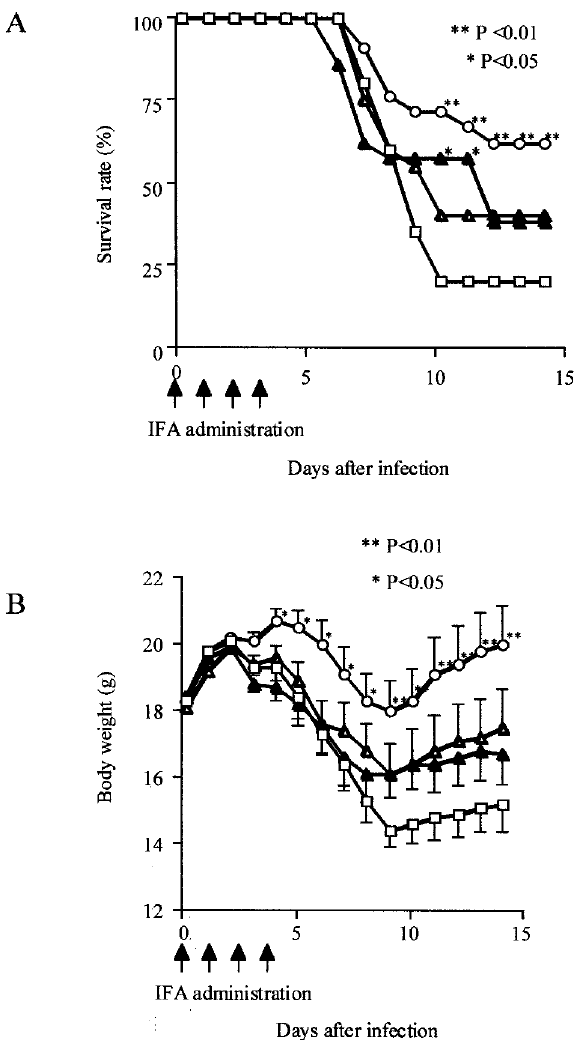
FIG. 1. (A) Effect of isoferulic acid (IFA) administration on the survival rate of influenza virus-infected mice. The IFA was given by oral administration at doses of 0.5mg/day (group A, filled triangle), 1.0mg/day (group B, open circle) and 2.0mg/ day (group C, open triangle) once daily during the initial 4 days (0–3 days after infection). As a control (open square), phosphate-buffered saline was given in the same manner. The data from 20 to 21 mice in each group were assessed by Fisher’s exact probability test. * Significant difference from the control with the indicated P value. (B) Effect of IFA administration on body weight loss of influenza virus- infected mice. The changes in body weight of the infected mice in each group shown in (A) were daily monitored and expressed as the mean ± SE (error bar) using the same symbols as (A). The data were assessed by unpaired t -test. *Significant difference from the control with the indicated P